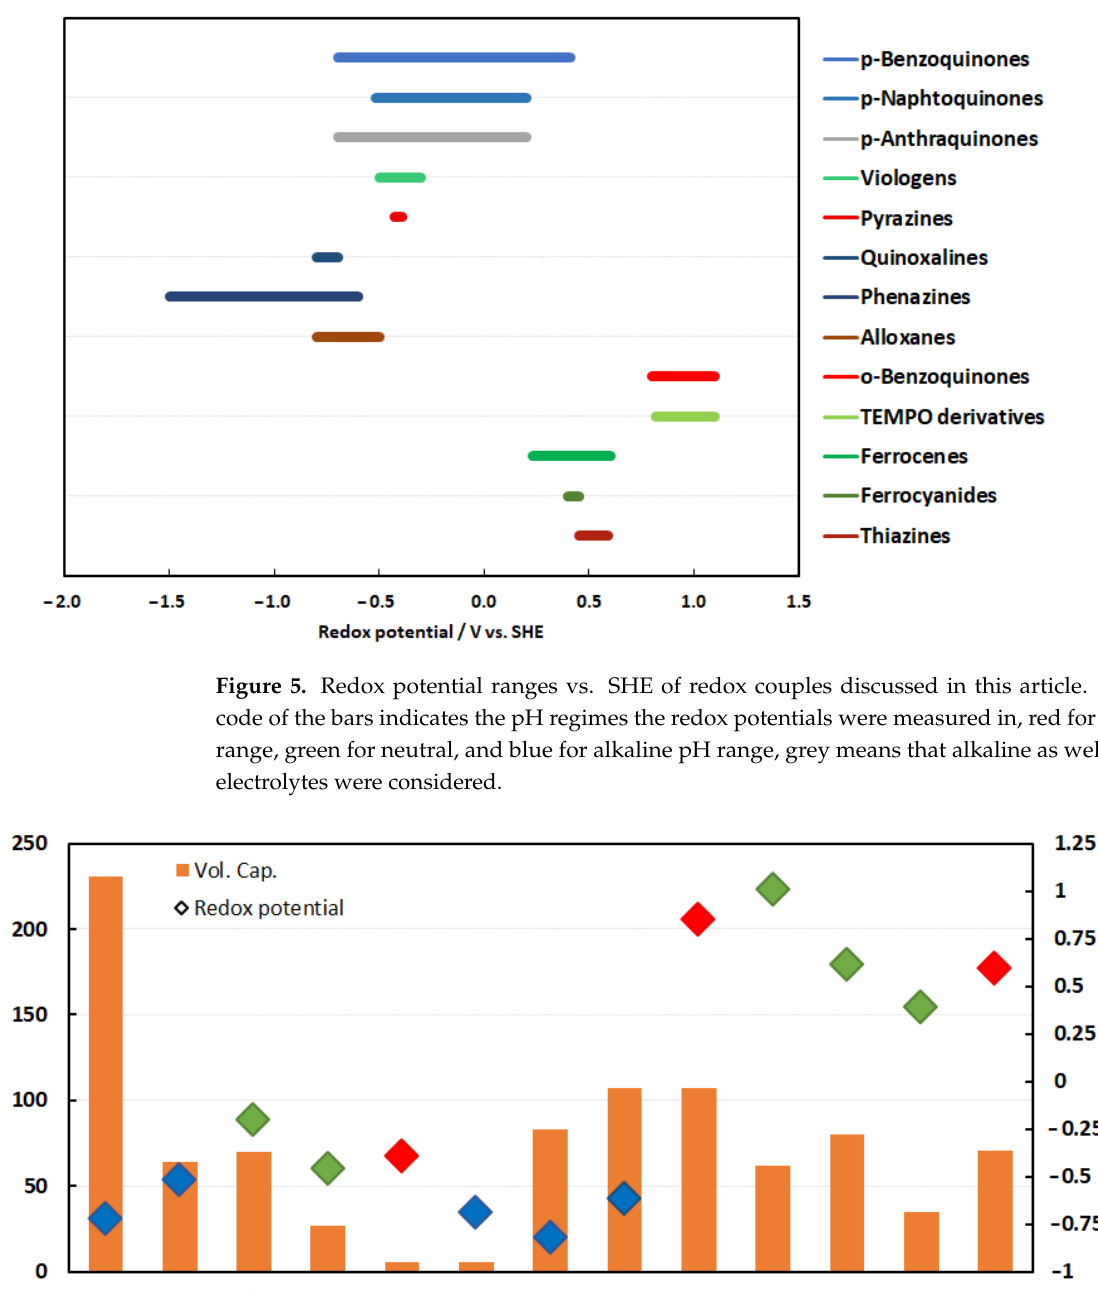
Figure 7: Family tree of the chemical motives for organic redox ‐ active molecules that could act as negolytes in aqueous organic redox flow batteries. Bigger connecting lines indicate more citations in the literature. 3.1.1. p ‐ Quinones From various chemistries that have been tested for RFB, the organic compounds from the quinone group were among the first candidates who brought the attention to the field of organic RFB. 3.1.1.1. Quinones (one ring)